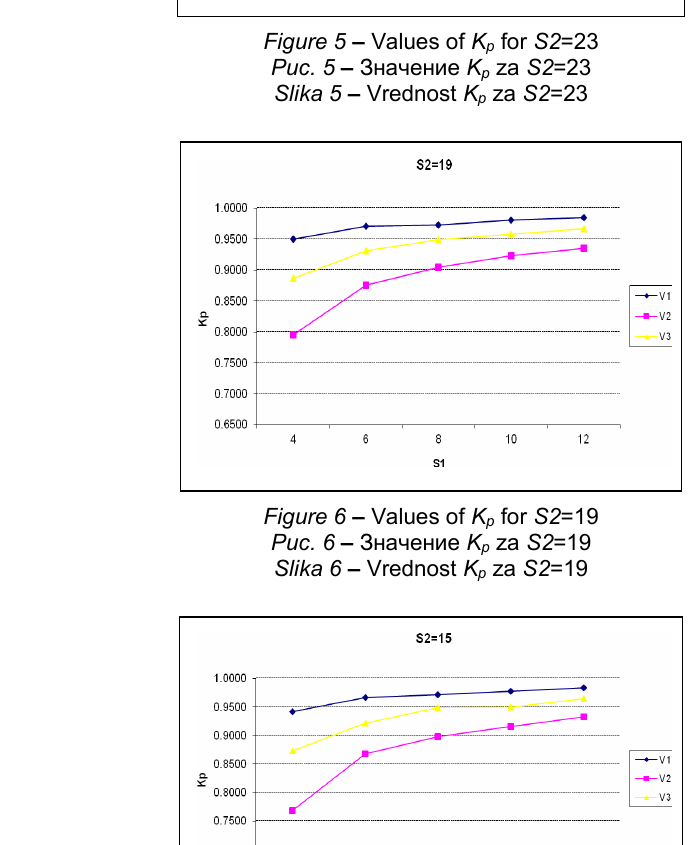
Figure 5 – Values of K p for S2 =23 Рис . 5 – Значение K p za S2 =23